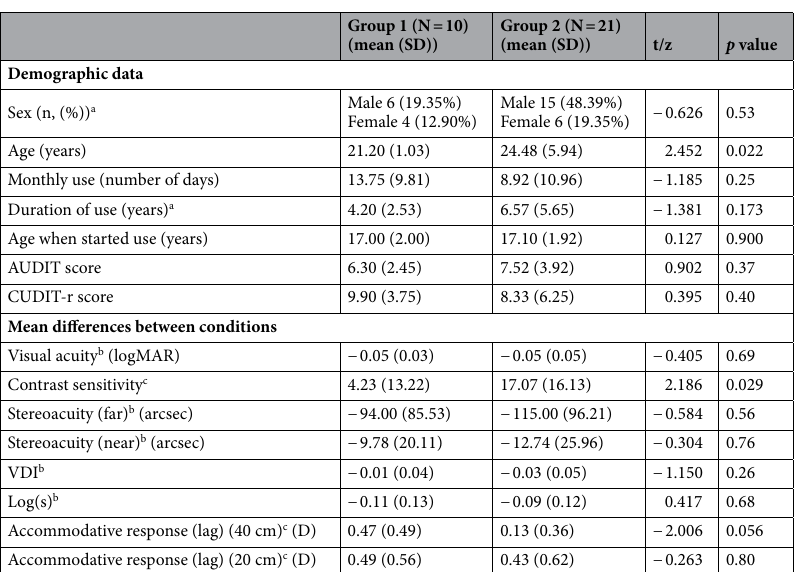
Table 3. Demographic data and mean differences between conditions (baseline-smoking cannabis) for each visual parameter for the two groups classified according their subjective perception of how cannabis affects their vision. a Mann–Whitney U test. b Negative value indicates worsening after smoking cannabis. c Positive value indicates worsening after smoking